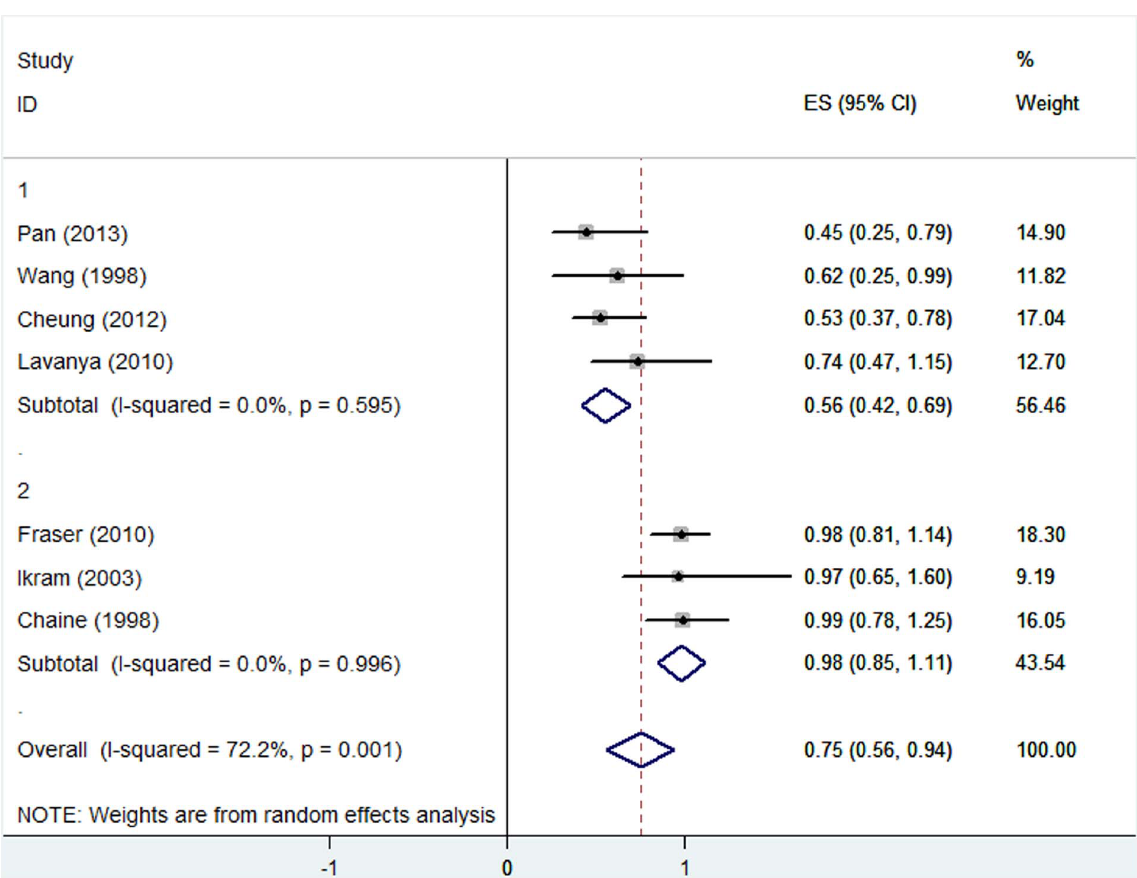
Figure 6. Myopia subgroups and early AMD prevalence: forest plot of risk estimates for early AMD prevalence and myopia stratified by geographic location (Asia or non-Asia subgroups). CI, confidence interval.